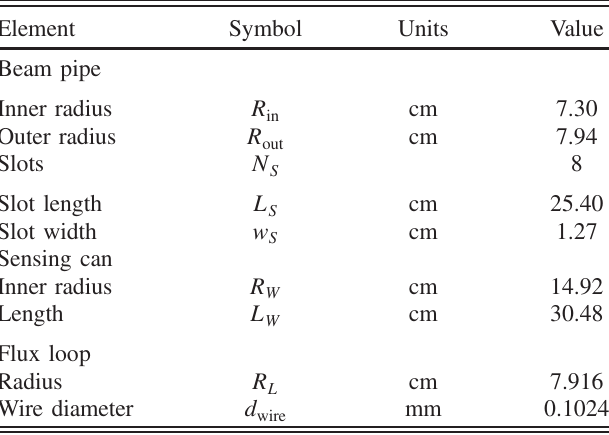
TABLE I. DML apparatus dimensions [21].